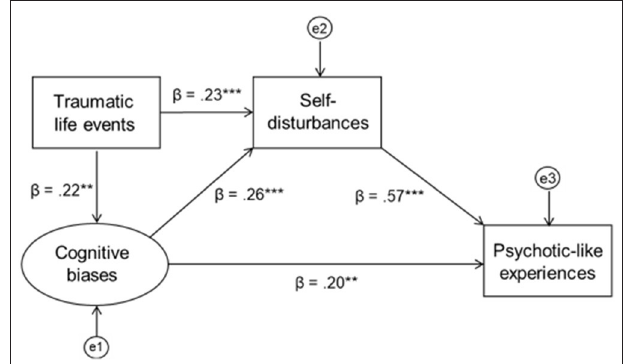
FIGURE 3 | The model of the indirect relationship between childhood trauma and psychotic-like experiences with self-disturbances and cognitive biases as the potential mechanisms underlying this